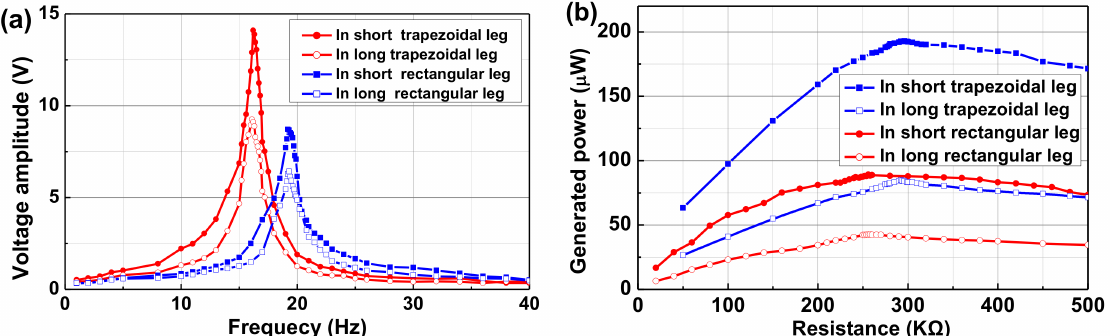
Figure 9. Experimental results for Case 1-based prototypes with the di ff erent locations for the piezoelectric plate: ( a ) voltage vs. frequency and ( b ) power vs. load resistance.